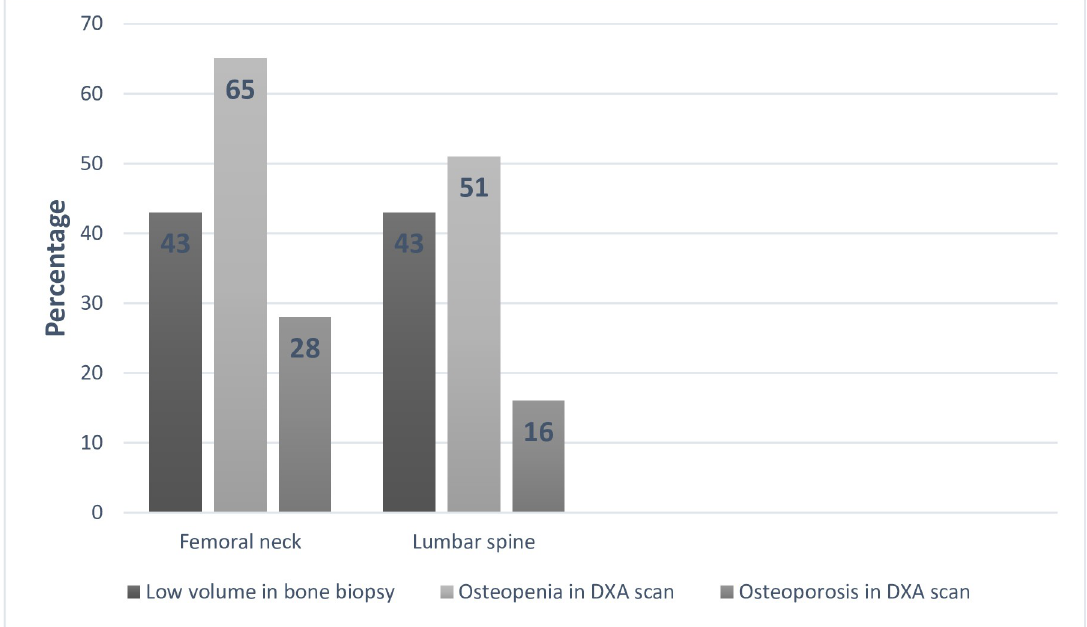
Fig 4. The diagnostic overlap of low bone volume on bone biopsy vs. osteoporosis in DXA scan.